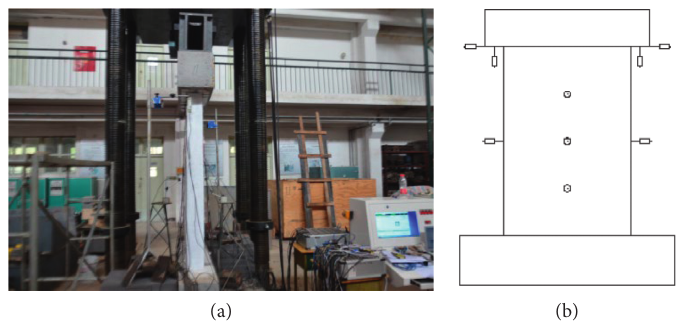
Figure 2: Arrangement of test loading device and displacement meter. (a) Test loading device. (b) Arrangement of the specimen dis- placement meter.